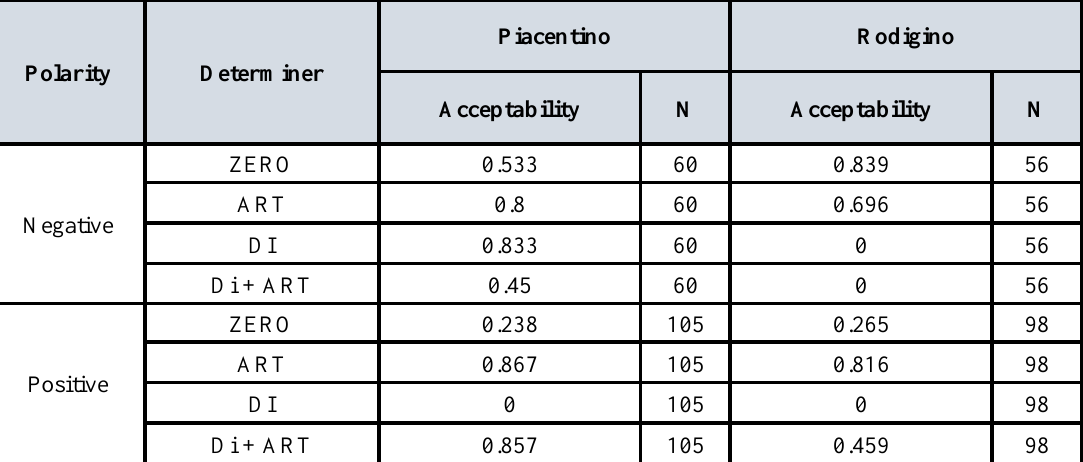
Table 5. Proportion of acceptable realizations (“Acceptability”) and number of collected judgements (“N”) as a function of polarity class, determiner type and